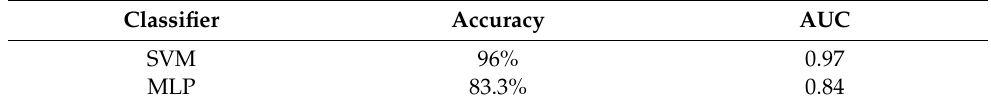
Table 5. Comparison between